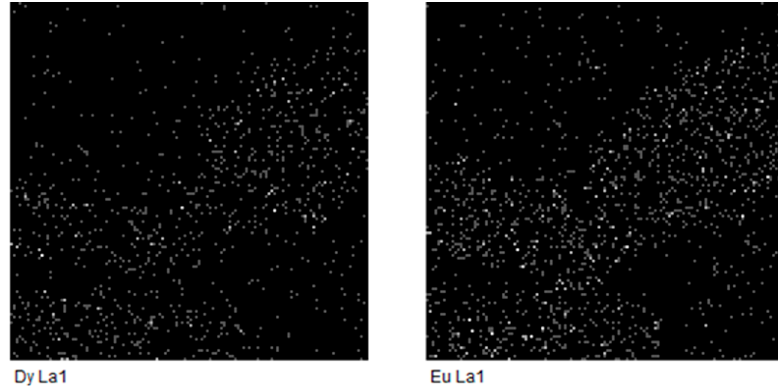
Figure 4. SEM micrographs and relative maps of elements performed by EDS analysis for sample C.